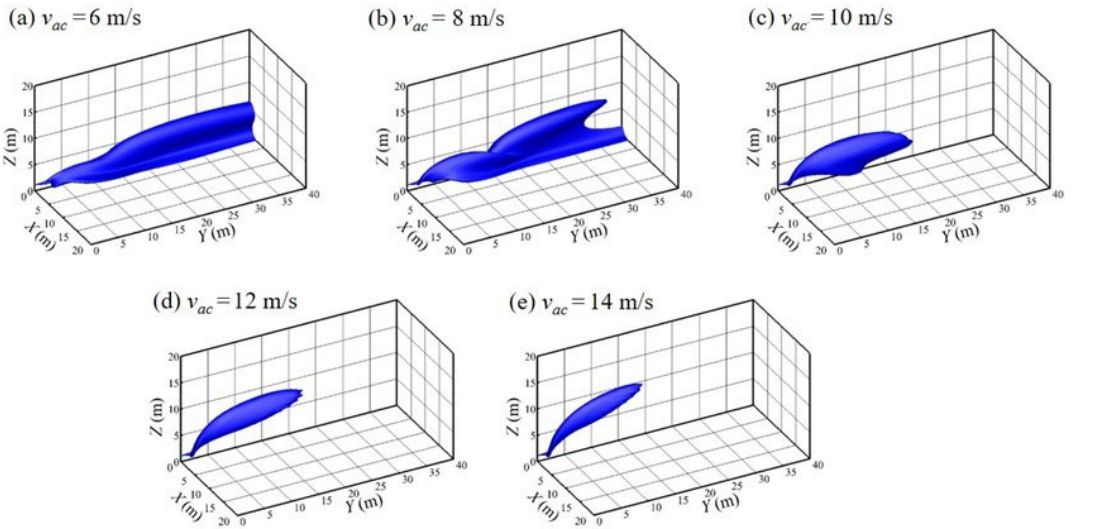
Figure 11. Iso-surface of 4% hydrogen concentration with various v ac values ( w ac = 0.25 m, d ac = 2 m, t = 100 s).